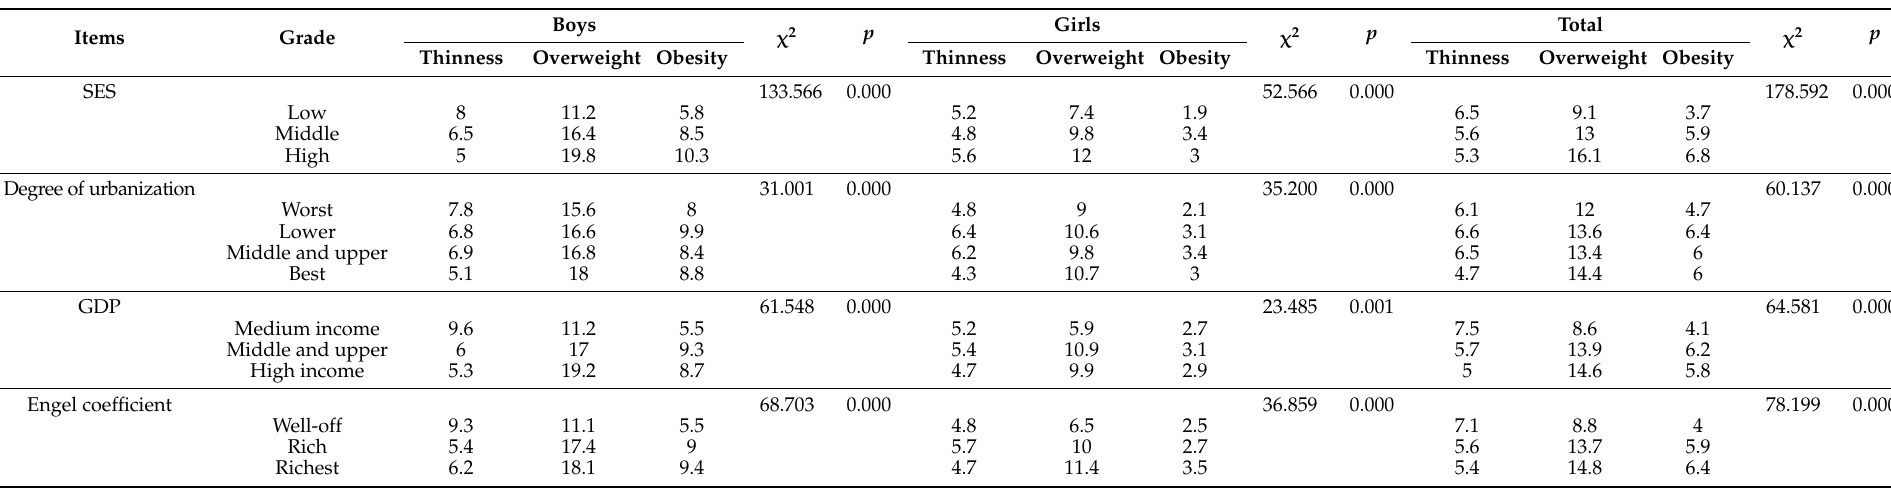
Table 5. Prevalence of overweight and obesity in children and adolescents under different socioeconomic conditions